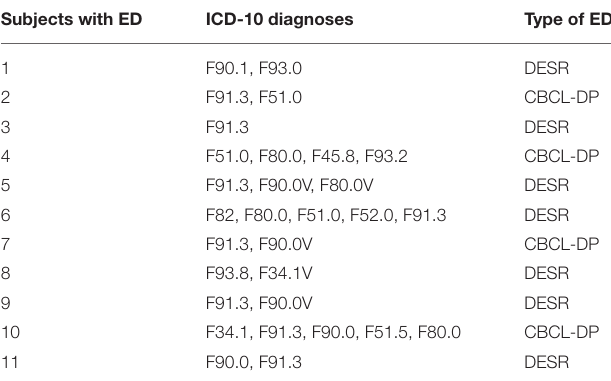
TABLE 2 | Listing of ICD-10 diagnoses per subject with ED.